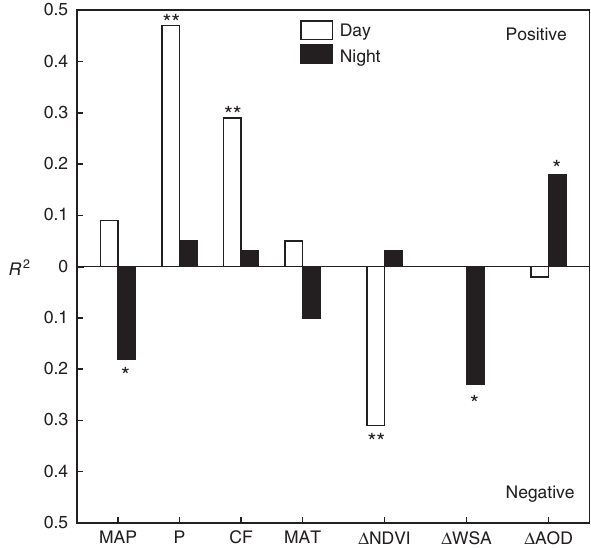
Figure 3 | Variance of the annual mean daytime and nighttime D T explained by different biophysical drivers. D AOD, difference in aerosol optical depth; D NDVI, urban-rural difference in normalized difference in vegetation index; P, population; D WSA, difference in white sky albedo; CF, crop fraction; MAP, annual mean precipitation; MAT, annual mean air temperature. Positive correlations are shown in the upper panel and negative correlations in the lower panels. Confidence levels are denoted by * P o 0.01 and ** P o Table 1 | Estimate of the haze contribution to the night-time UHI for three climate zones. Humid Semi-humid Semi-arid